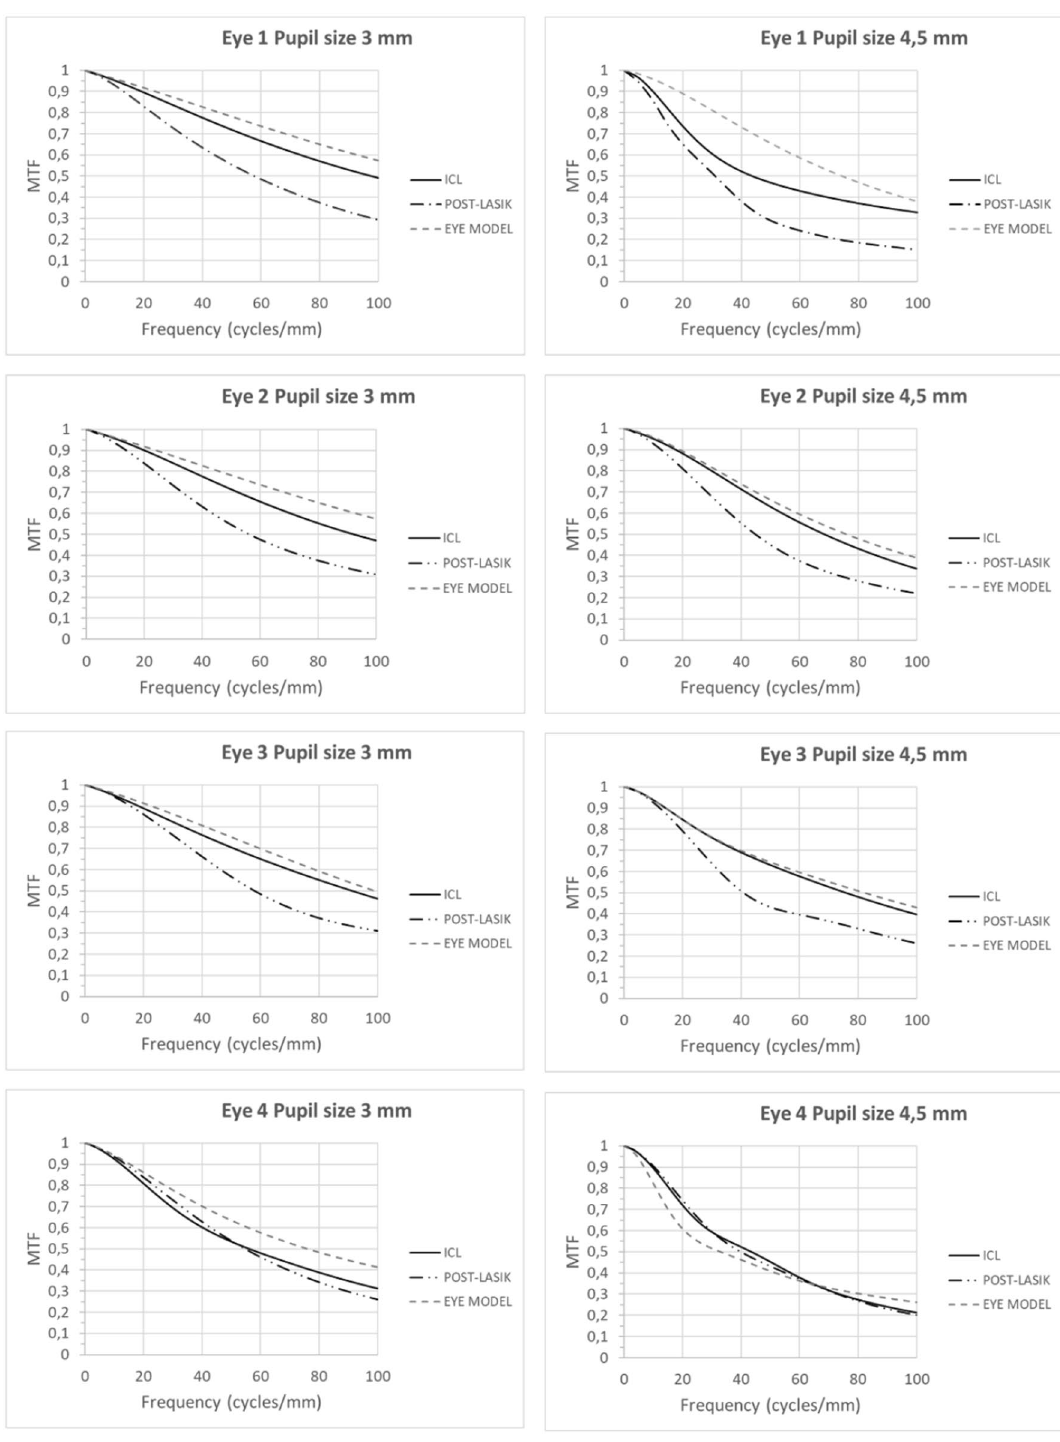
Figure 2. Modulation Transfer Function (MTF) up to 100 cycles/mm of the three eye models (eye model, ICL model and post-LASIK model) for the pupil sizes of 3 mm and 4.5